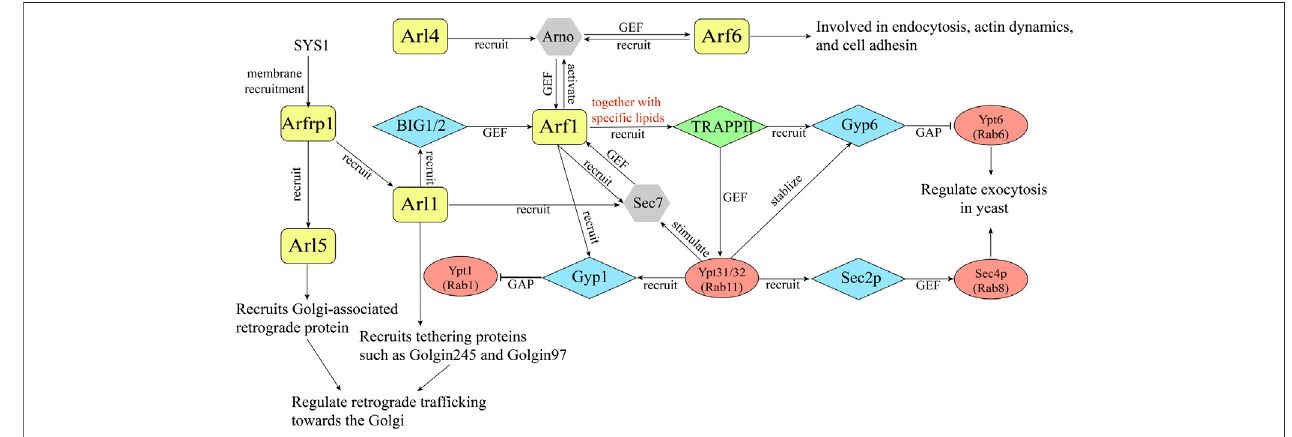
FIGURE 2 | A diagram illustrating an example of GTPase crosstalk between ARF family proteins and Rabs.